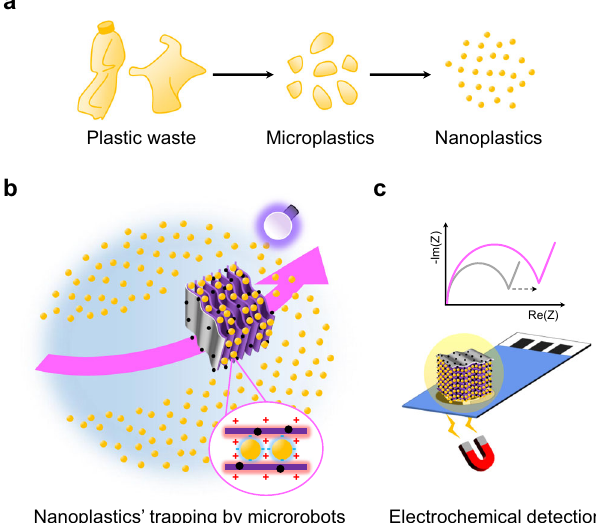
Fig. 1 Light-powered magnetic MXene-derived γ -Fe 2 O 3 /Pt/TiO 2 microrobots trap and detect nanoplastics. a Plastic waste in water fragments into micro- and nanoplastics. b Microrobots accelerate the removal of nanoplastics from water by trapping them on their surface, including the slits between multi-layer stacks, due to the combination of a powerful motion and a programmable electrostatic attraction. c Acting as self-propelled platforms for preconcentration, microrobots allow nanoplastics ’ detection by electrochemical impedance spectroscopy (EIS) using low-cost and portable electrodes in an electrolyte solution (yellow shading). The curves represent the impedance real (Re(Z)) and imaginary (-Im(Z)) parts as a function of the frequency (Nyquist plots) of microrobots before (gray) and after capturing nanoplastics